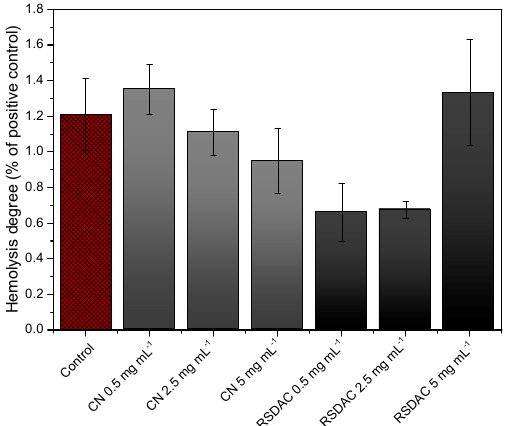
Figure 5. Hemolytic activity of Cladophora nanocellulose (CN) and RSDAC after 60 min incubation with whole blood. Results are expressed as percentage of the positive control (1% ( v/v ) Triton-X treated blood). Data represent mean ± standard error of the mean for n = 6.